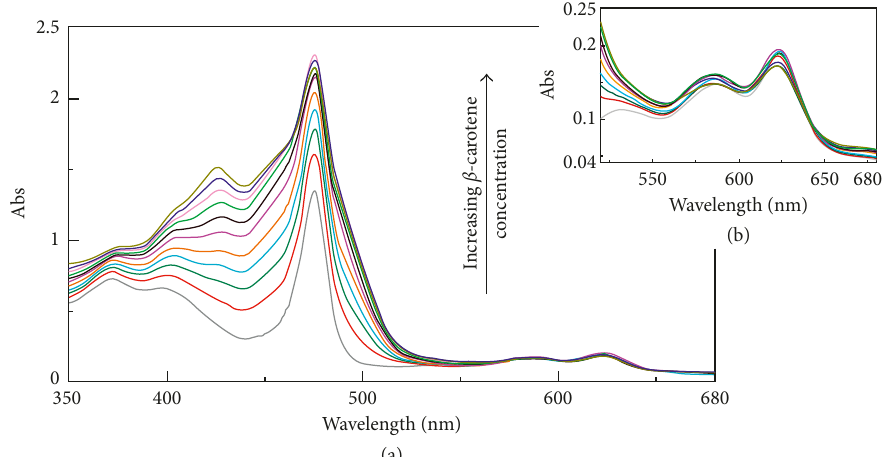
Figure 6: Overlapped UV-Vis spectra for the detection of β -carotene solution in ethanol by MnTTPCl solution in THF (a). Details of the isosbestic point at 645nm